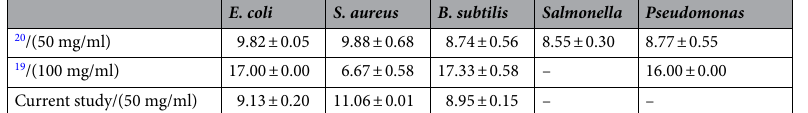
Table 5. Diameter of inhibition zone (mm) of bacterial growth of P. juliflora leaf ethanolic extract as obtained in three different